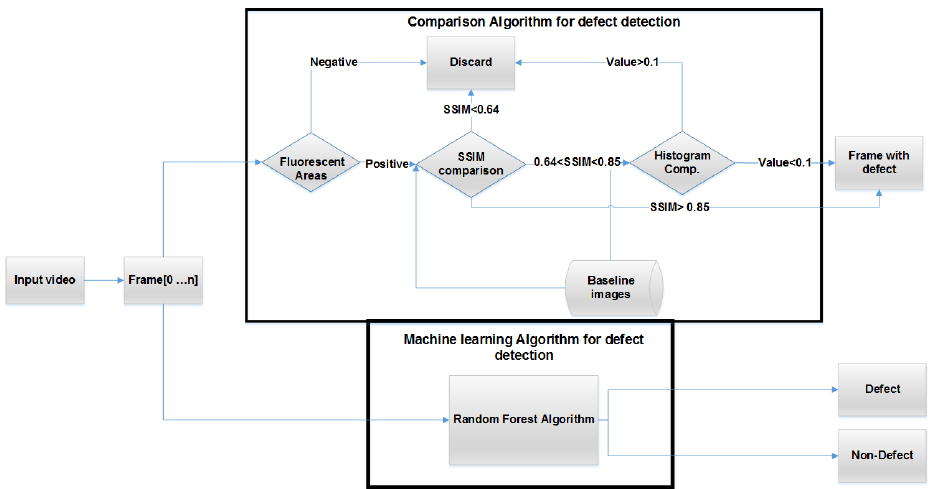
Figure 7. Flowchart of both the proposed defect recognition methods, the one with the combine use of SSIM and Histogram comparison and the Random Forest.